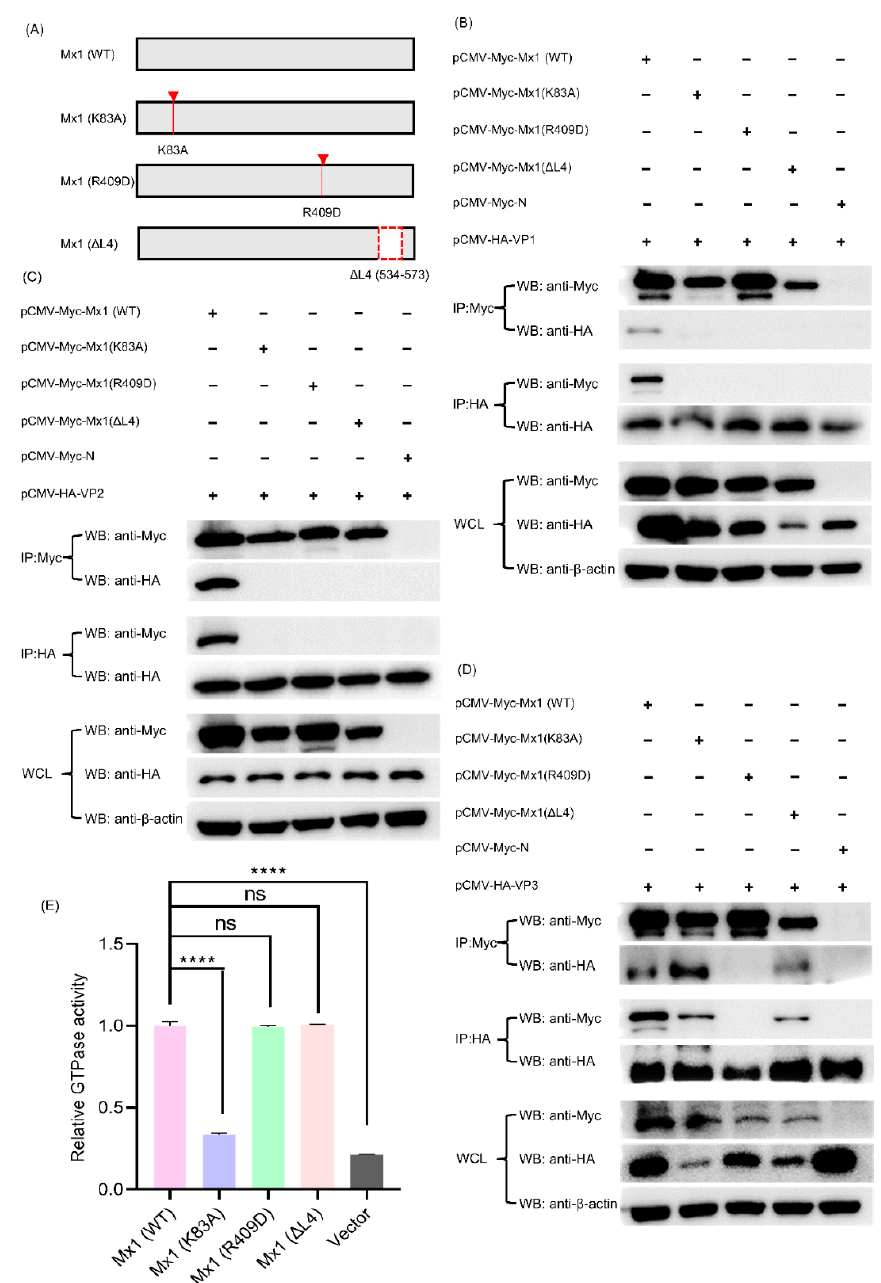
Figure 10. The GTPase, oligomerization and interaction activities of Mx1 are required for its interaction with the SVA VP1, VP2 and VP3 proteins. ( A ) Construction strategy of the three Mx1 mutants (Mx1 (K83A), Mx1 (R409D), and Mx1 ( Δ L4)) with a single-site mutation of K83A, R409D, and a deletion of amino acid residues 534 ‒ 573 (denoted by a red dashed box), respectively, using pCMV-Myc-Mx1 as the backbone plasmid. ( B ) Co-IP analysis of wild-type (WT) and mutant Mx1 proteins with SVA VP1 protein. ( C ) Co-IP analysis of WT and mutant Mx1 proteins with SVA VP2 protein. ( D ) Co-IP analysis of WT and mutant Mx1 proteins with SVA VP3 protein. HEK293T cells were co-transfected with 1.25 µ g of pCMV-HA-VP1, pCMV-HA-VP2 or pCMV-HA-VP3, and 1.25 µ g of pCMV-Myc-Mx1, pCMV-Myc-Mx1(K83A), pCMV-Myc-Mx1(R409D), pCMV-Myc-Mx1( ∆ L4) or pCMV-Myc-N. At 36 hpt, the cells were harvested to prepare WCL for Co-IP analyses using mouse anti-Myc and -HA mAbs. ( E ) Determination of the GTPase activity of WT and mutant Mx1